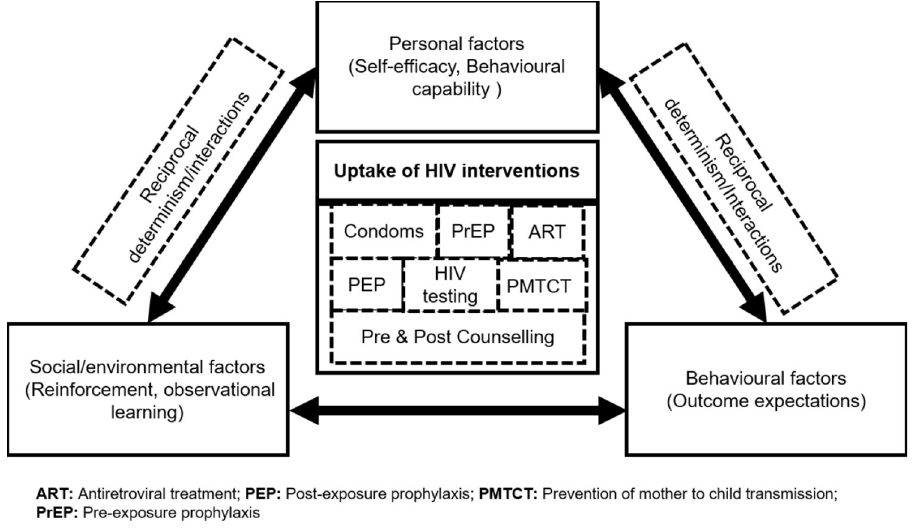
Fig 1. Adaptation of the social cognitive